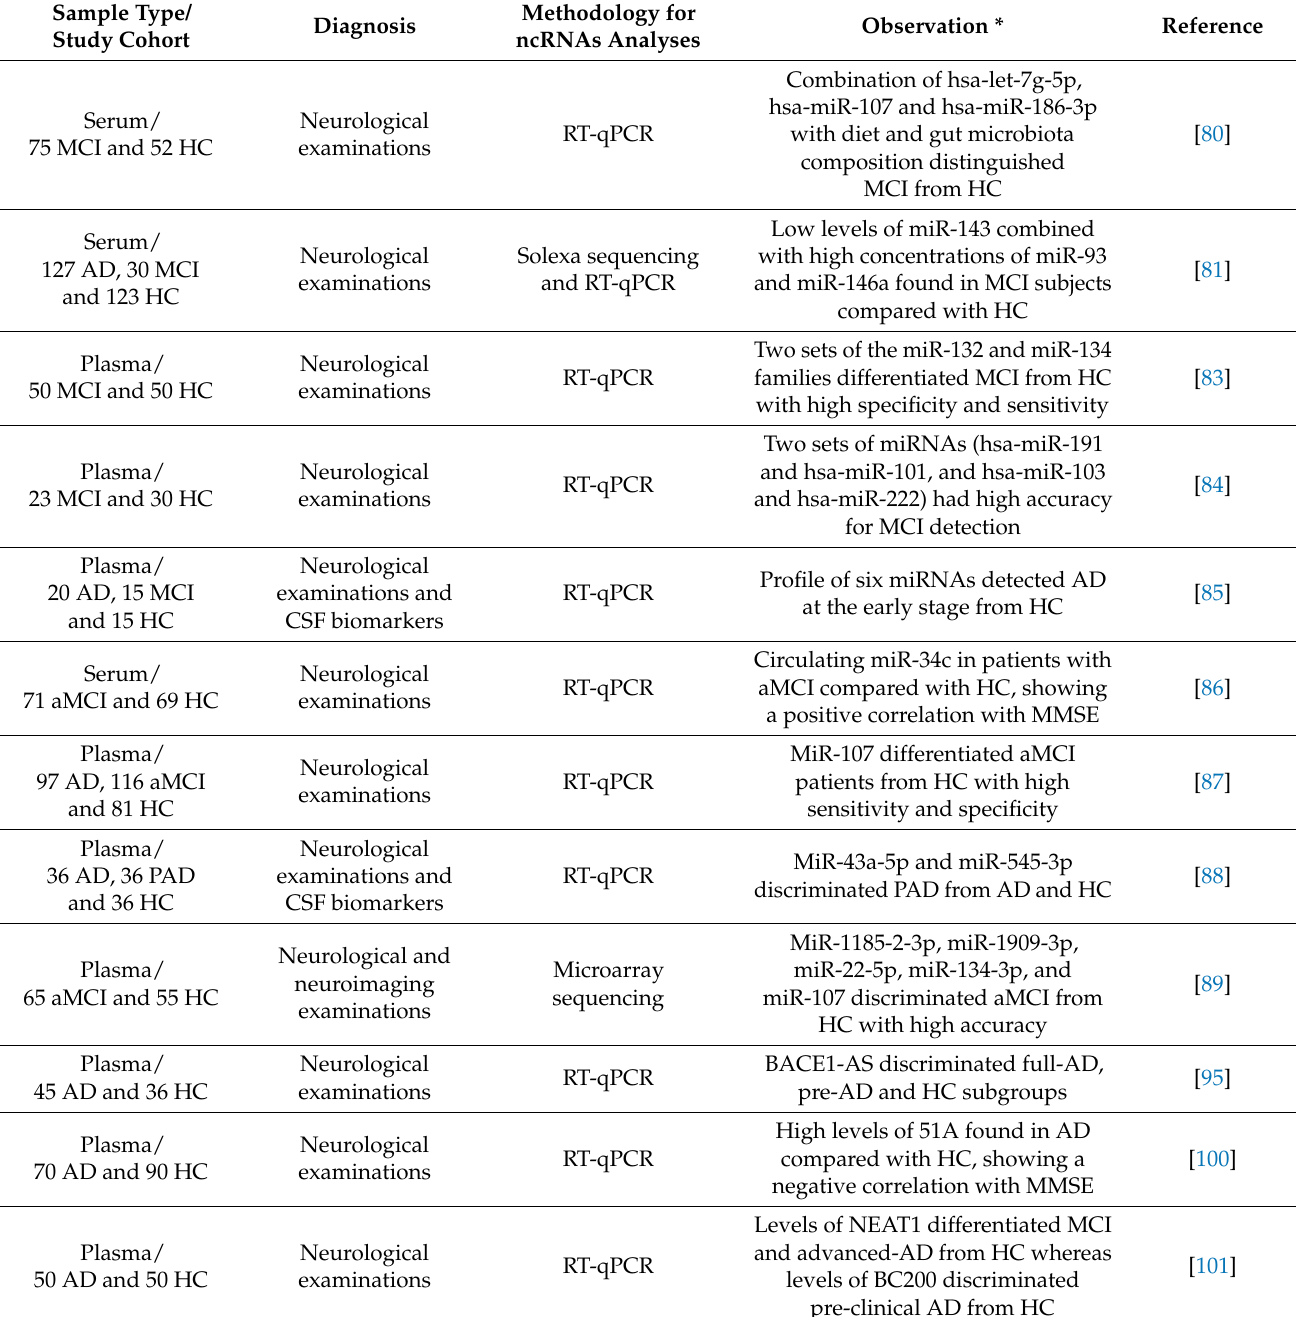
Table 2. Summary of ncRNAs studies for early detection of